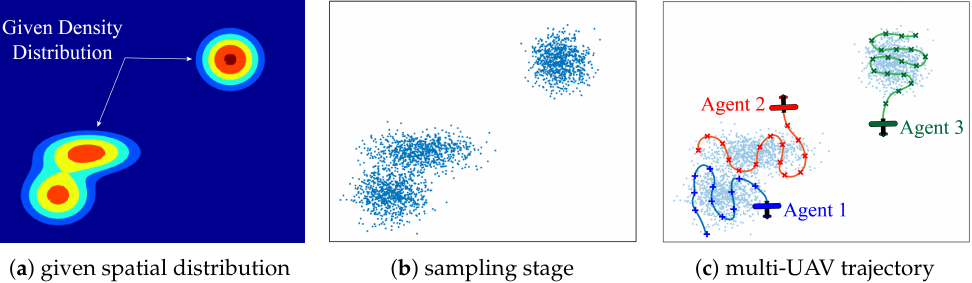
Figure 2. Procedure to generate the multi-UAV trajectory using the optimal transport